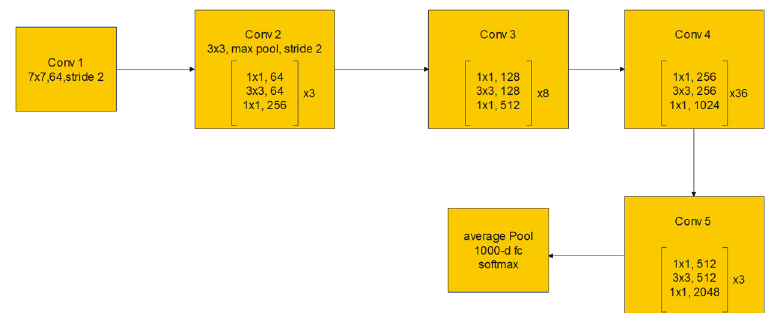
Figure 4. ResNet-152 architecture.